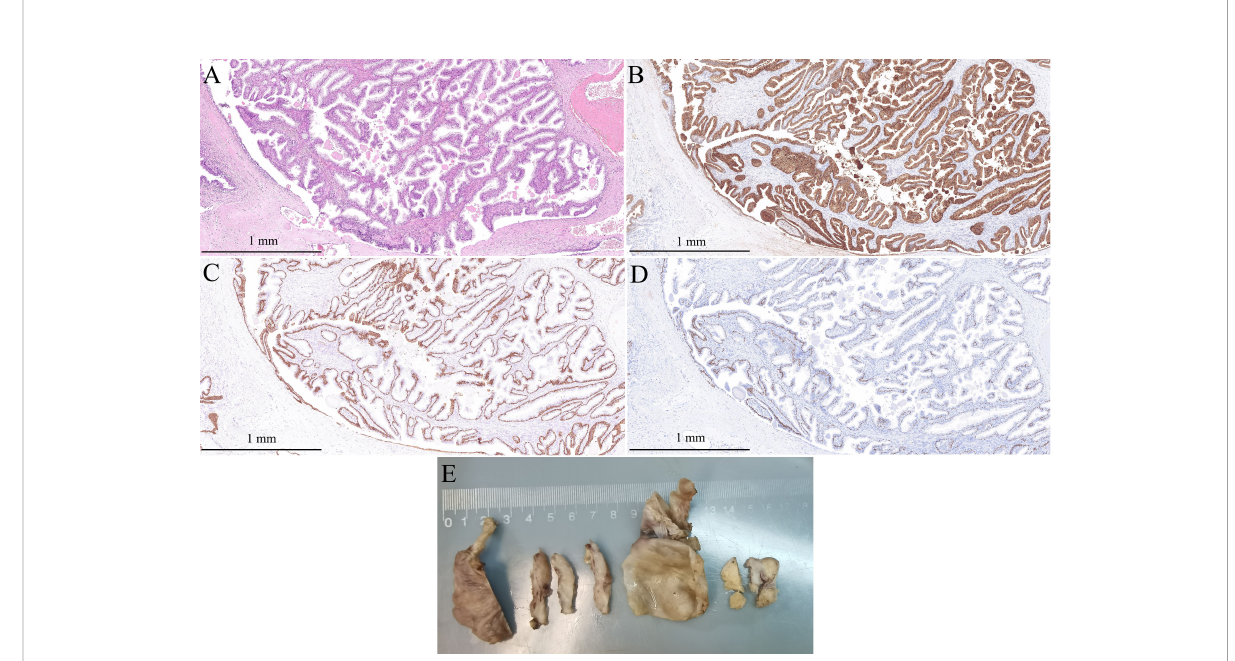
FIGURE 2 Pathological diagnosis of the mono-cystic mass. (A) HE staining slide shows branching papillary structure, lining benign double-layer prostatic epithelial cells (original magni fi cation, ×100); (B) The cells lining the cysts were strongly and uniformly positive for PSA (original magni fi cation, ×100); (C) Basal cells were immunohistochemical staining for high-molecular weight cytokeratin (34 b E12) (original magni fi cation, ×100); (D) Basal cells were immunohistochemical staining for p63 (original magni fi cation, ×100); (E) The gross